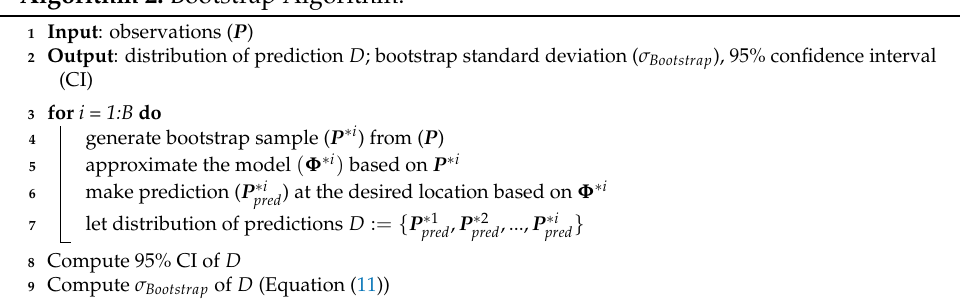
Algorithm 2: Bootstrap